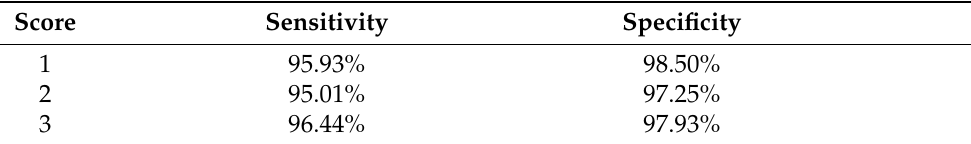
Table 7. The specificity and sensitivity for each TUG score on the test set.